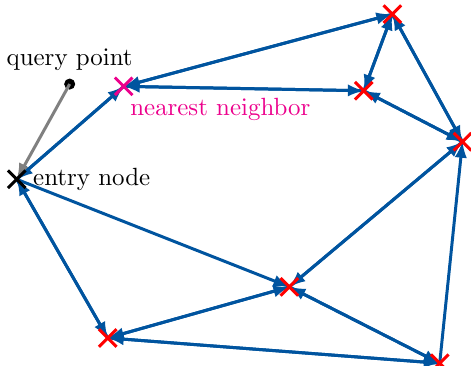
Figure 5. Visualization of the approximate nearest neighbor search in a neighborhood graph. The al- gorithm traverses through the neighborhood graph greedily. θ t to be optimized, blue arrows indicate neighborhood